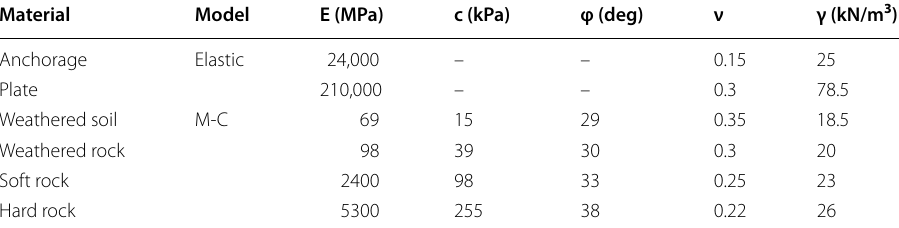
Table 1 Material properties used in the analyses